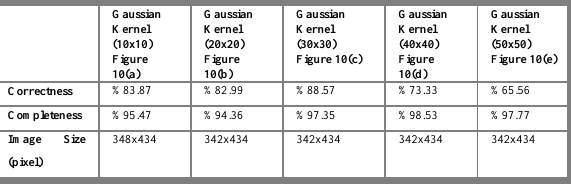
Table 3: Evaluation of Different Size of Gaussian Kernel